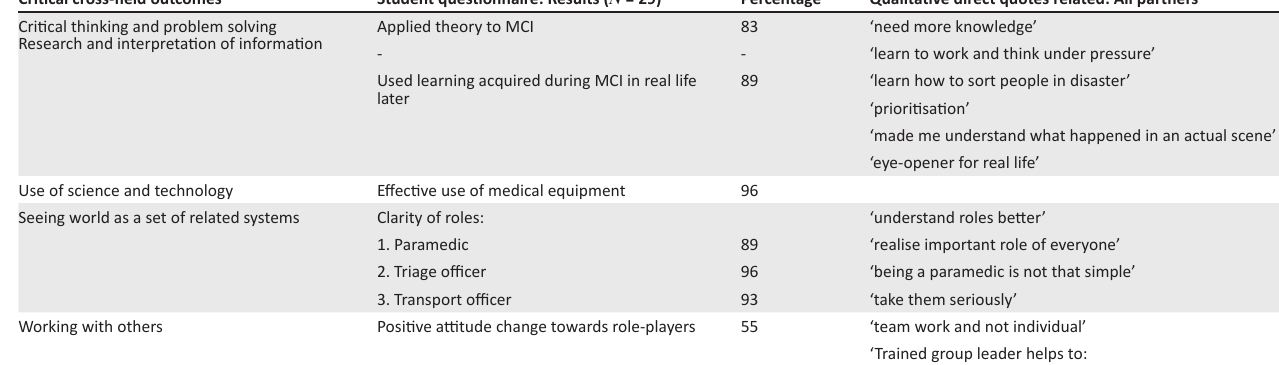
TABLE 4: Results of action research set one according to the critical cross-field outcomes. Critical cross-field